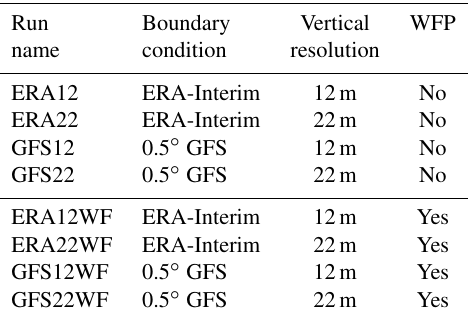
Table 2. List of WRF simulations and their